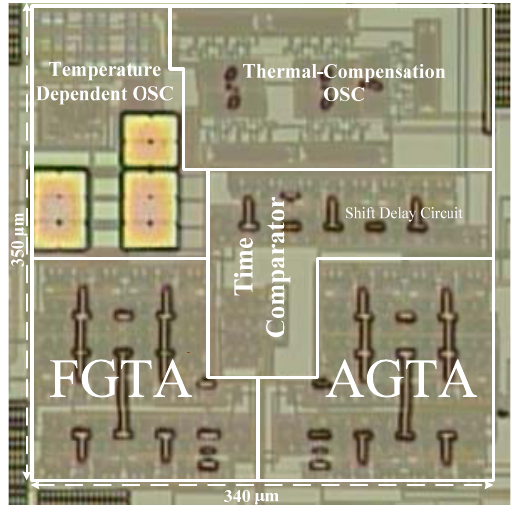
Figure 12. Microphotograph of the proposed circuit.